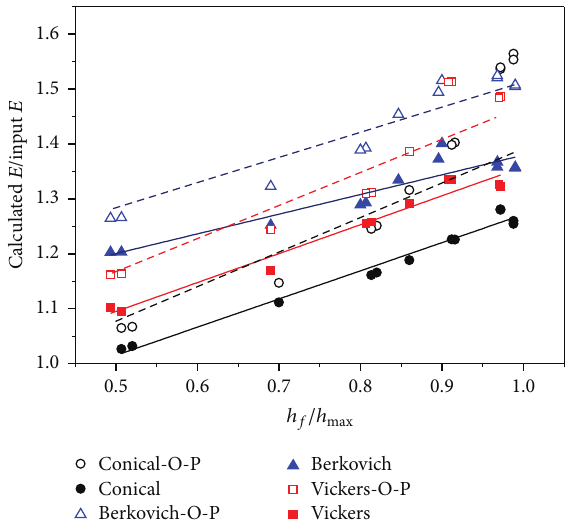
Figure 12: Influence of ℎ 𝑓 /ℎ max on 𝐻/𝑌 . The solid icons stand for the hardness derived from true projected contact areas, while the hollow icons represent those derived by Oliver and Pharr model